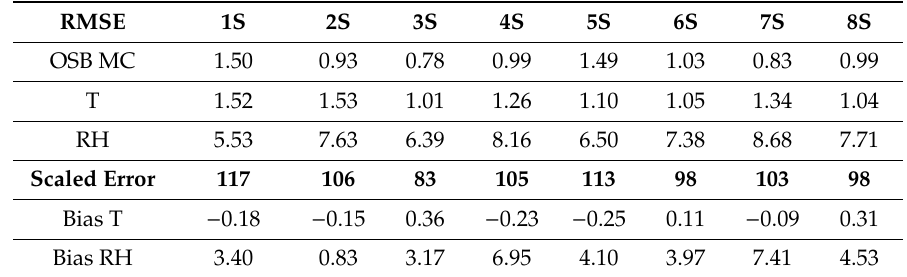
Table 3. Total scaled error for model of each wall assembly.